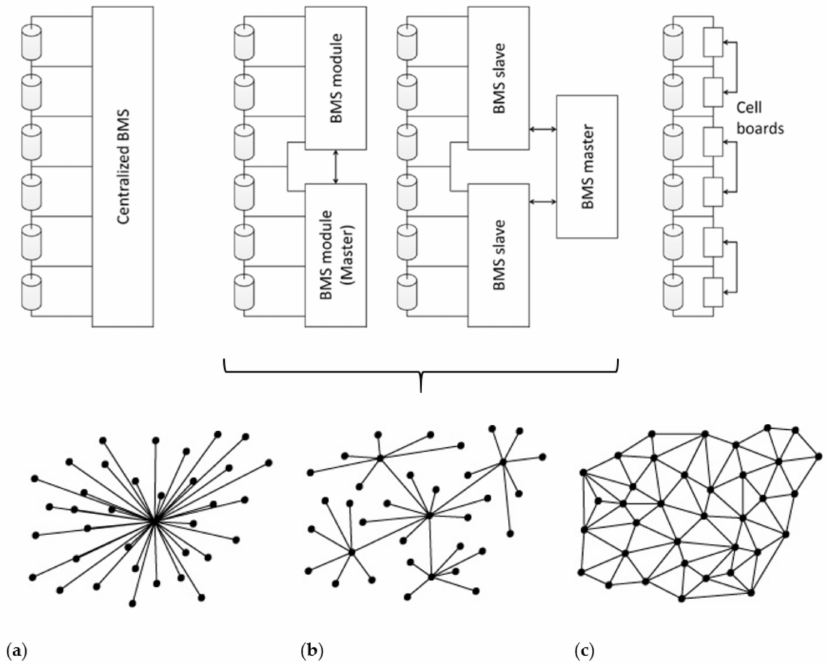
Figure 4. Basic types of BMS topologies ( top ) and their corresponding control networks ( bottom ): ( a ) centralized; ( b ) decentralized (modular and master-slave topologies), and ( c )